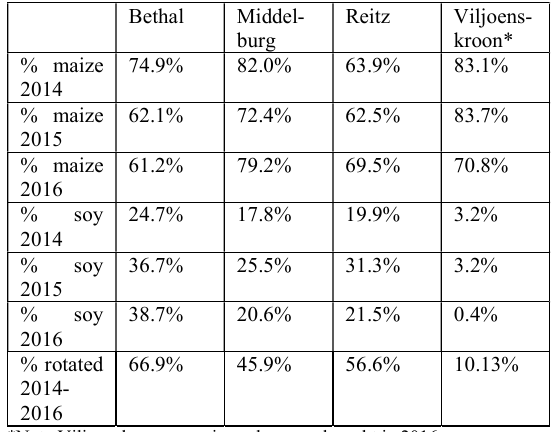
Figure 28. Sentinel 2A image next to the Orange river with pivot field boundaries overlaid